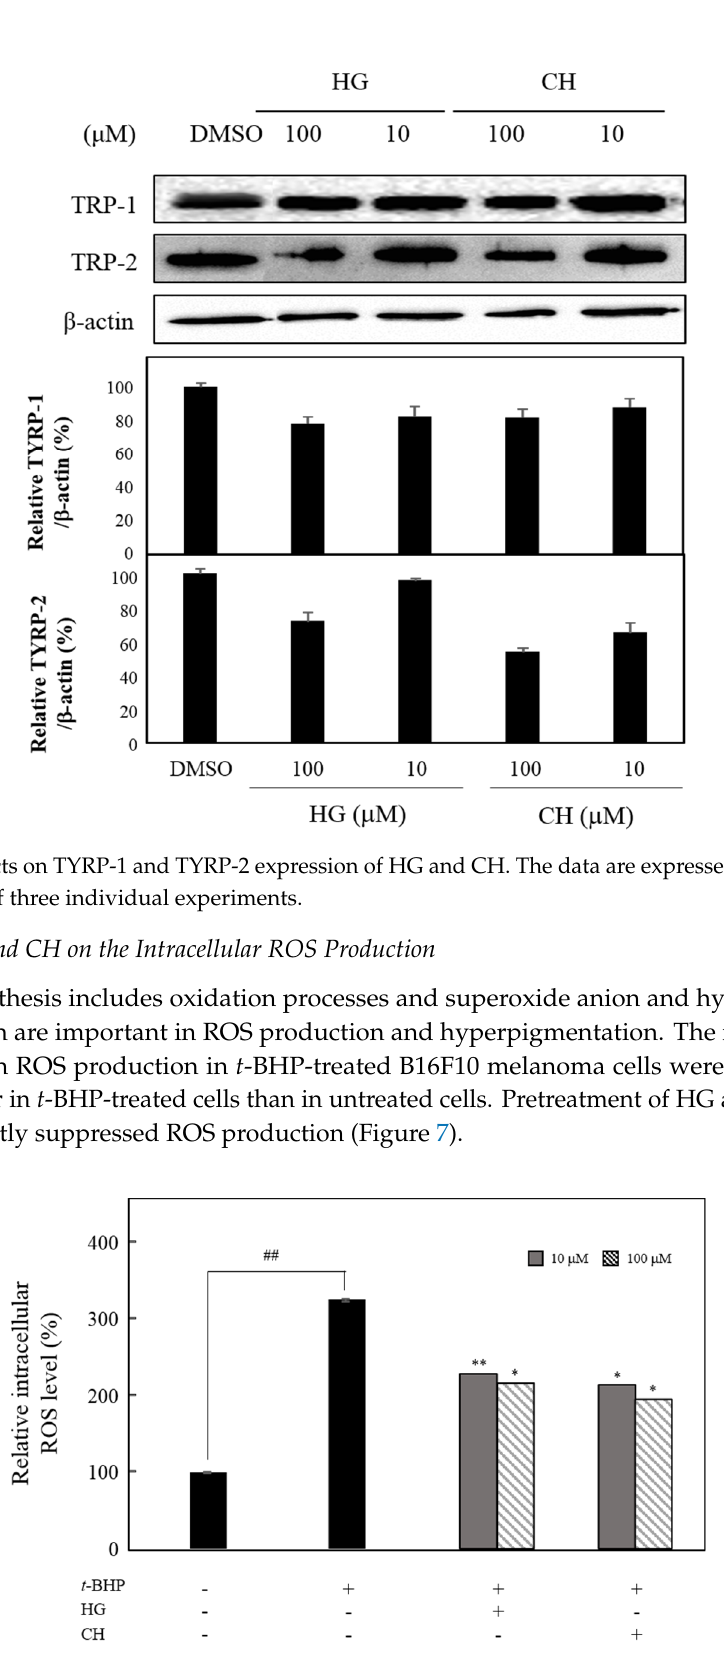
Figure 7. Effect of HG and CH on intracellular ROS levels in t-BHP-treated B16F10 mouse melanoma cells. The data are expressed as the mean ± SD ( n = 3) of three individual experiments. ## p < 0.01 vs. non-treated group; * p < 0.05 and ** p < 0.01 vs. t -BHP-treated group.